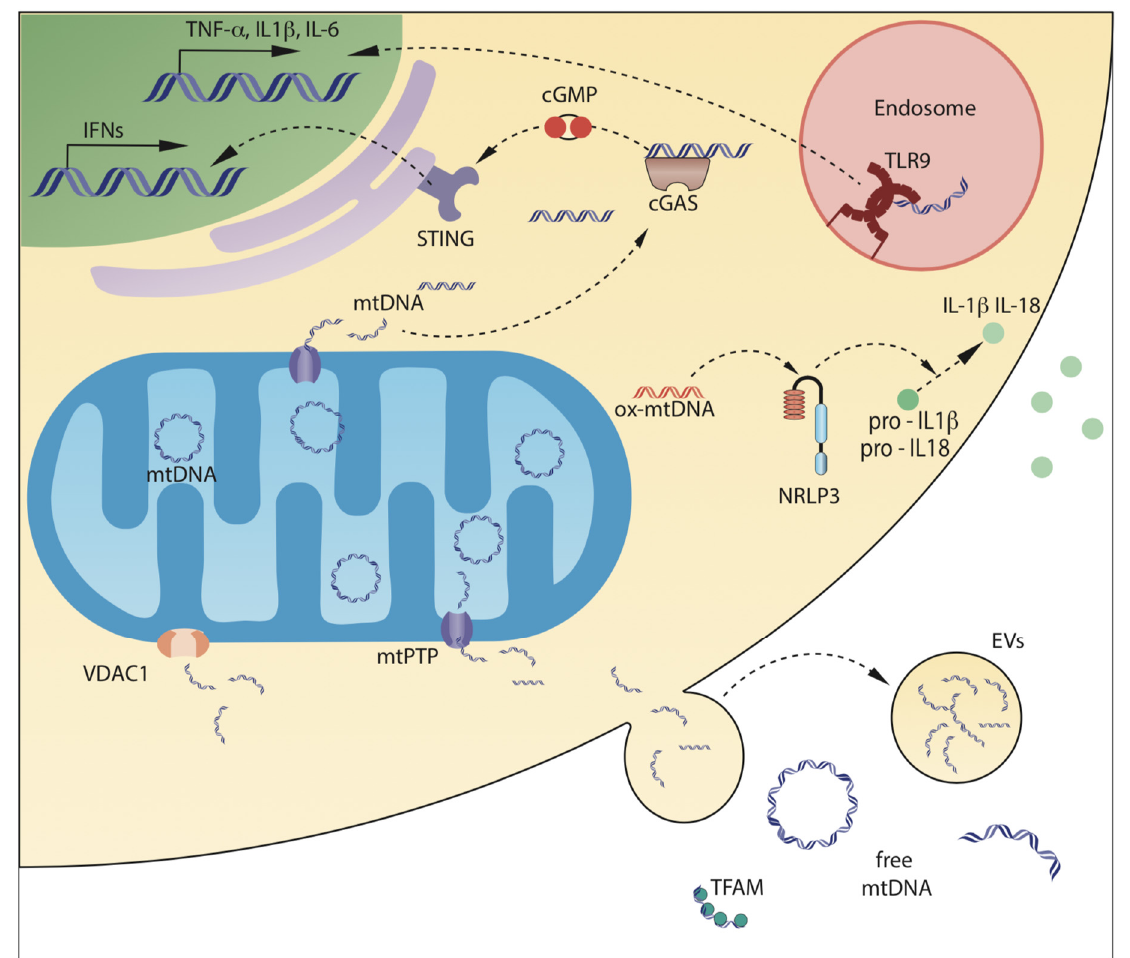
Figure 2. Mechanisms of mtDNA release from mitochondria, and of mtDNA sensing. mtDNA can be released by mitochondria into the cytosol, or in the extracellular space, either as circular molecules, DNA fragments, or DNA associated with mitochondrial proteins. Leakage from mDNA can be mediated by mitochondrial Permeability Transition Pore (mPTP), that causes swelling of the mitochondrial inner chamber and loss of impermeability of the Mitochondrial Inner Membrane (MIM), and by pores on the Mitochondrial Outer Membrane (MOM), formed by pro-apoptotic protein BAX or by the oligomers of the mitochondrial porin voltage-dependent anion-selective channel 1 (VDAC1). Once in the cytosol, mtDNA can interact with cGAS, which activates a pathway leading to enhanced transcription of type 1 interferons, or with NLRP3, particularly when oxidized. NLRP3 inflammasomes activate IL-1 β and IL-18 by post-translational cleavage. Cells can also take up mtDNA from surrounding environment by phagocytosis; once in the endosomes, mtDNA can interact with the Toll-like receptor 9, which activates a pathway leading to transcription of pro-inflammatory cytokines TNF- α , IL-1 β , and IL-6. Finally, mtDNA can be released outside the cells either by passive release, mediated by rupture of plasma cell membrane integrity, or by active release through extracellular vesicles.